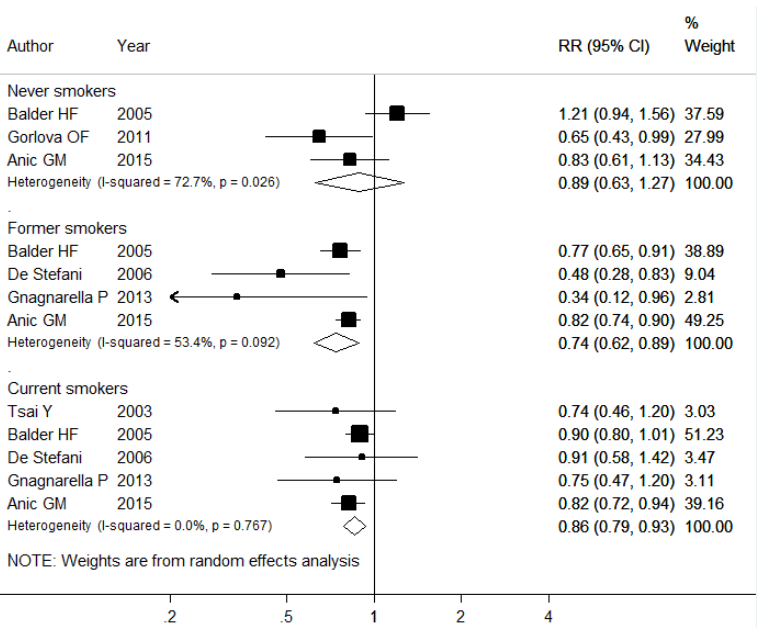
Figure 3. Forest plot of heathy dietary pattern and lung cancer risk, stratified by smoking status.